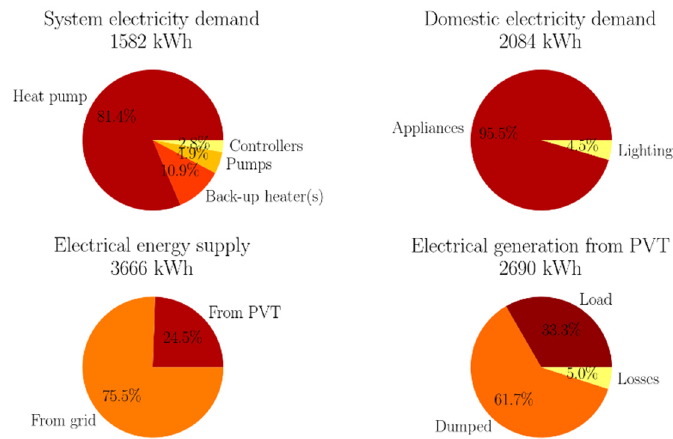
Figure 11. Annual electrical energy balance of the system and the